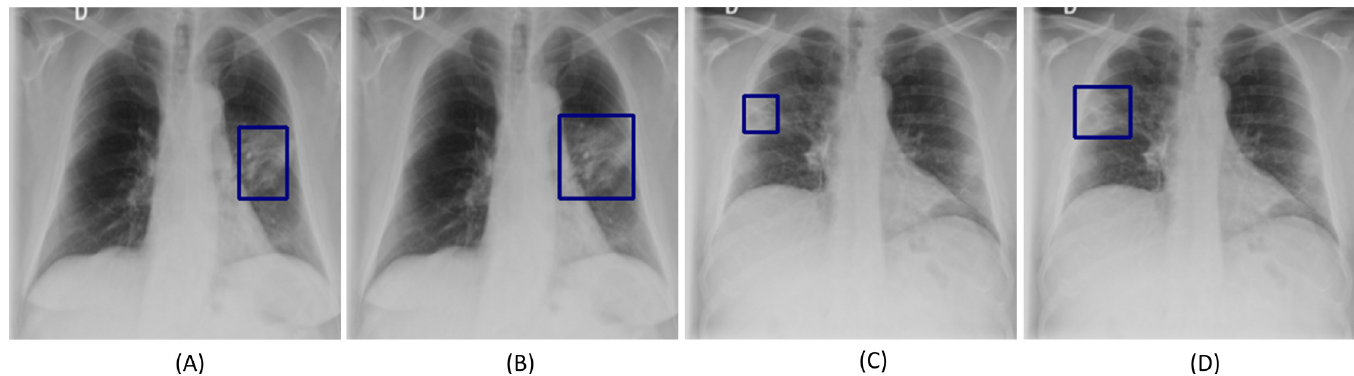
Fig 8. Examples showing inter-reader variability in annotating COVID-19 disease ROI. (A) and (B) show the annotations (bounding boxes in blue) of Rad-1 and Rad- 2, respectively, for a given COVID-19 disease labeled image; (C) and (D) shows the GT annotations of Rad-1 and Rad-2, respectively for another COVID-19 disease labeled image.